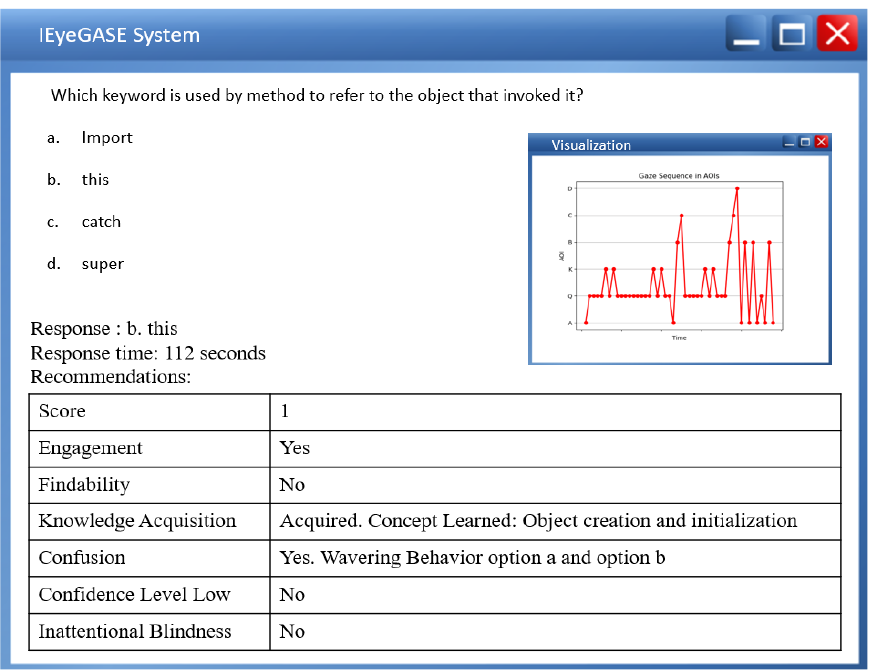
Figure 14. Personalized feedback of a good learner exhibiting wavering